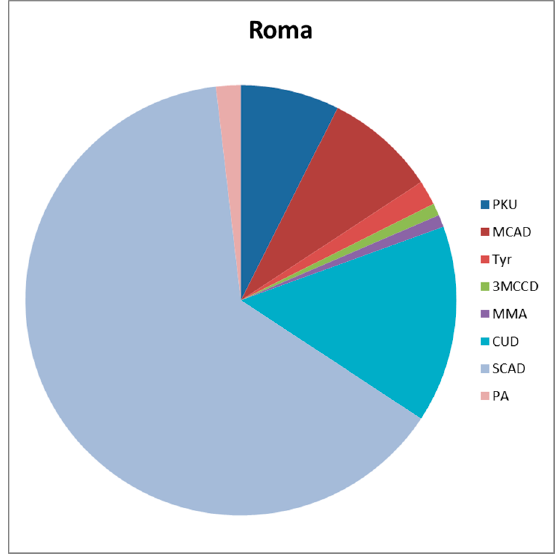
Figure 2. Spectrum of IEMs in the Roma newborns.